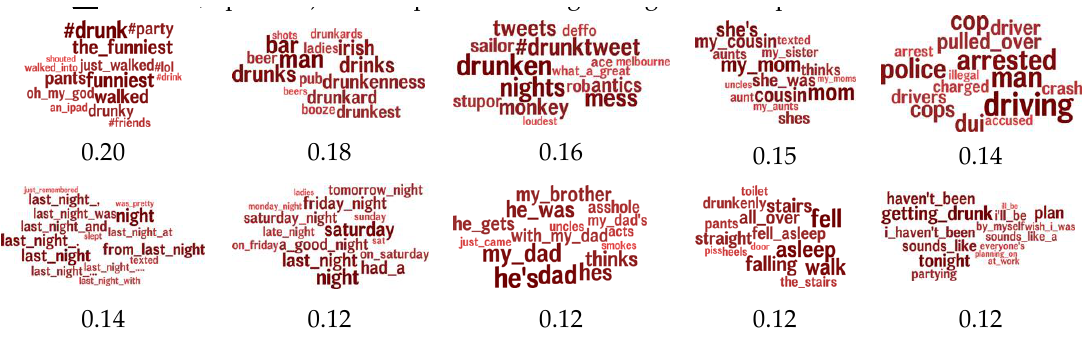
Figure 3. Drunk topics most positively correlated with county-level excess drinking. Reported Pearson’s r , p < 0.05 after Benjamini–Hochberg correction.